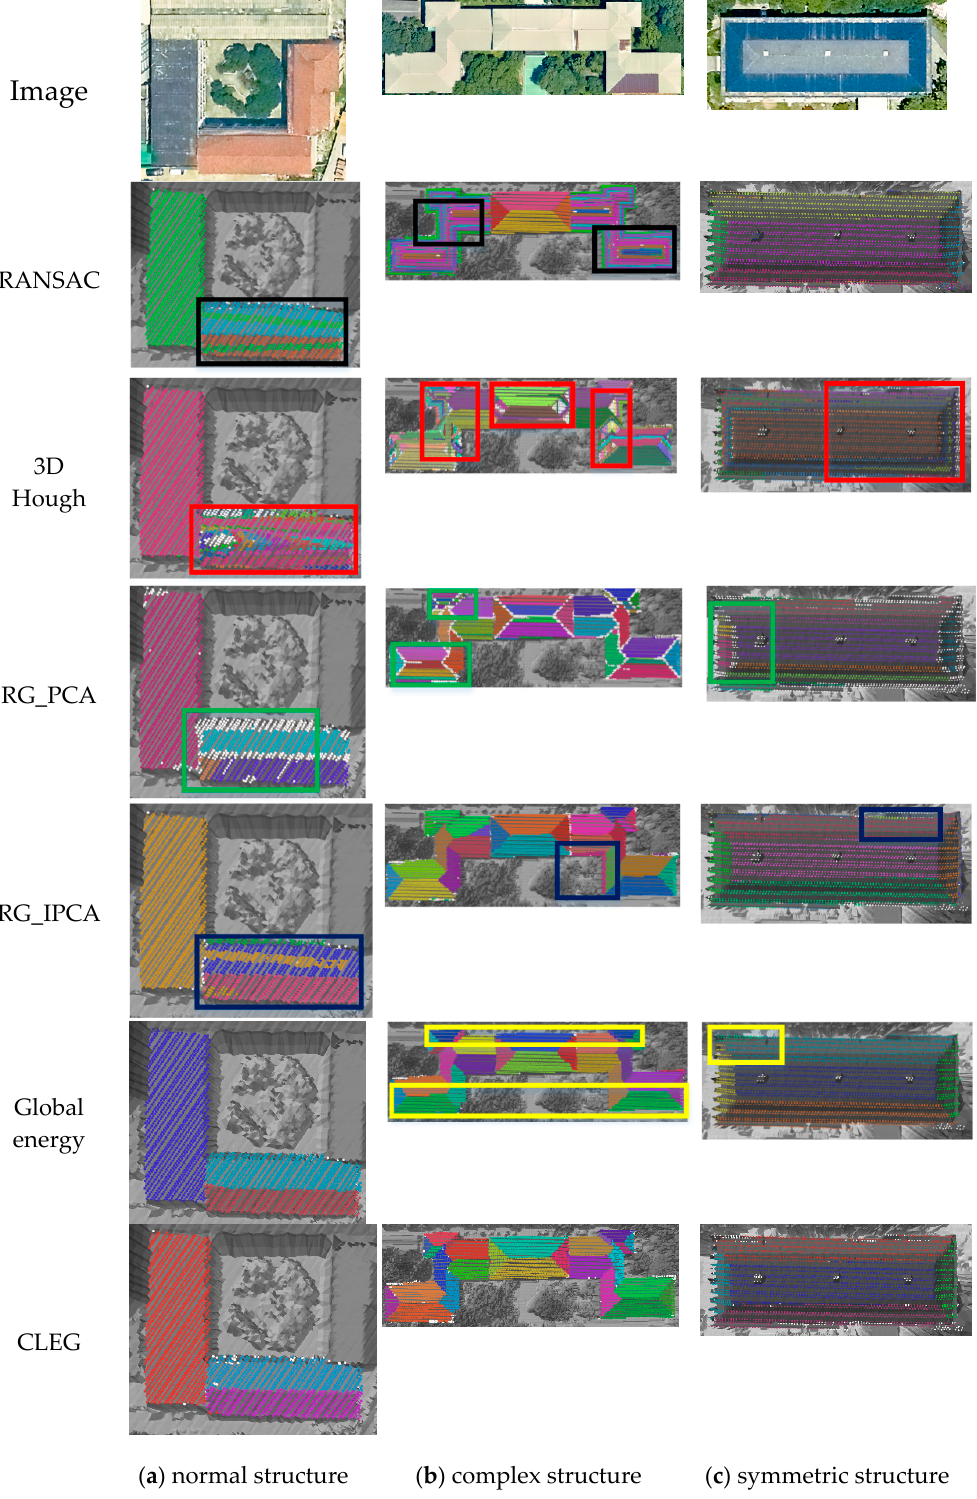
Figure 9. Segmentation of roof points in the Wuhan area. ( a ) normal structure; ( b ) complex structure; ( c ) symmetric structure.